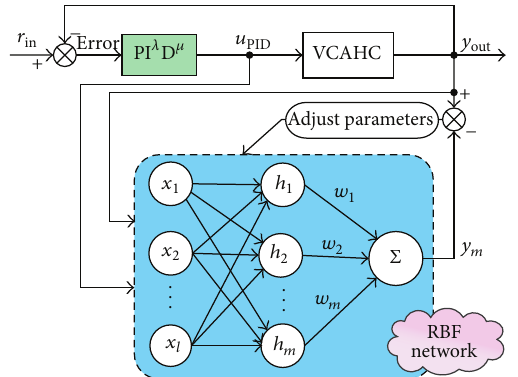
Figure 4: The structure and principle of RBF network tuning PI 𝜆 D 𝜇